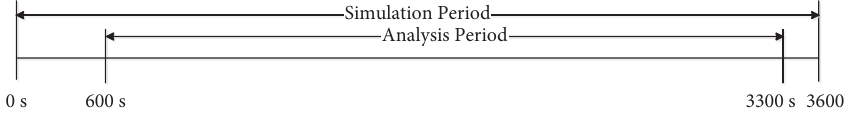
Figure 6: Time frame for analysis period during one-hour simulation. Table 3: Train departure time for different train